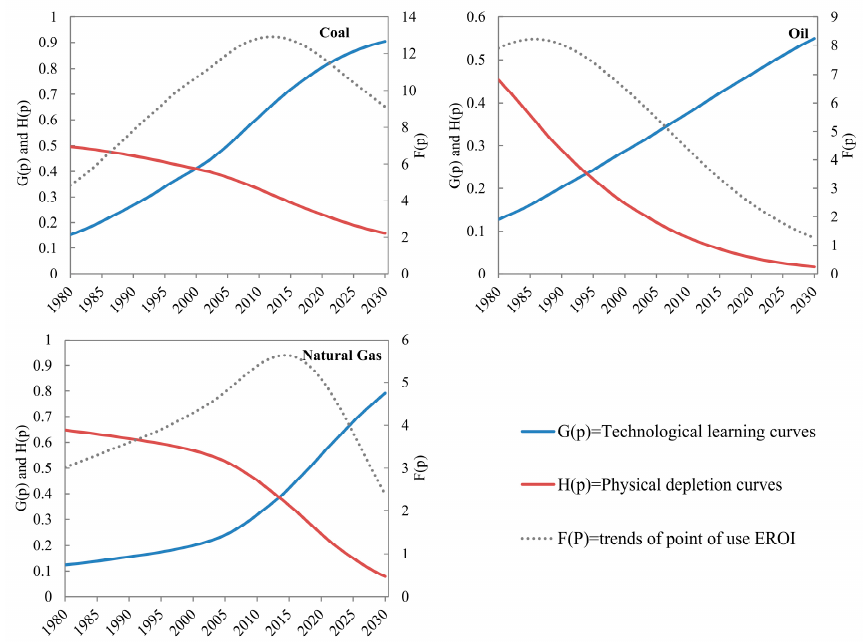
Figure 8. Technological and physical depletion component for Chinese fossil fuels.